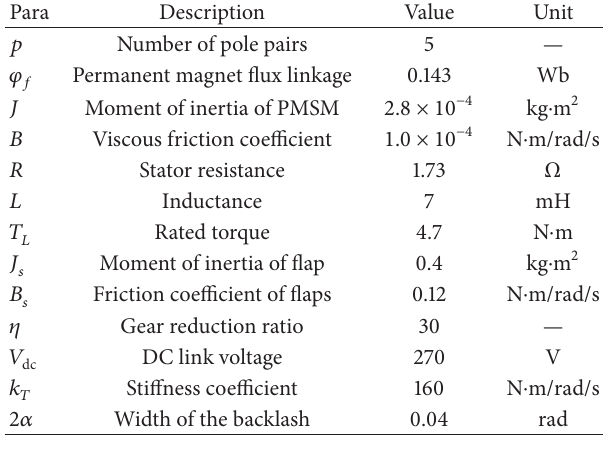
Table 1: Parameters of the system.